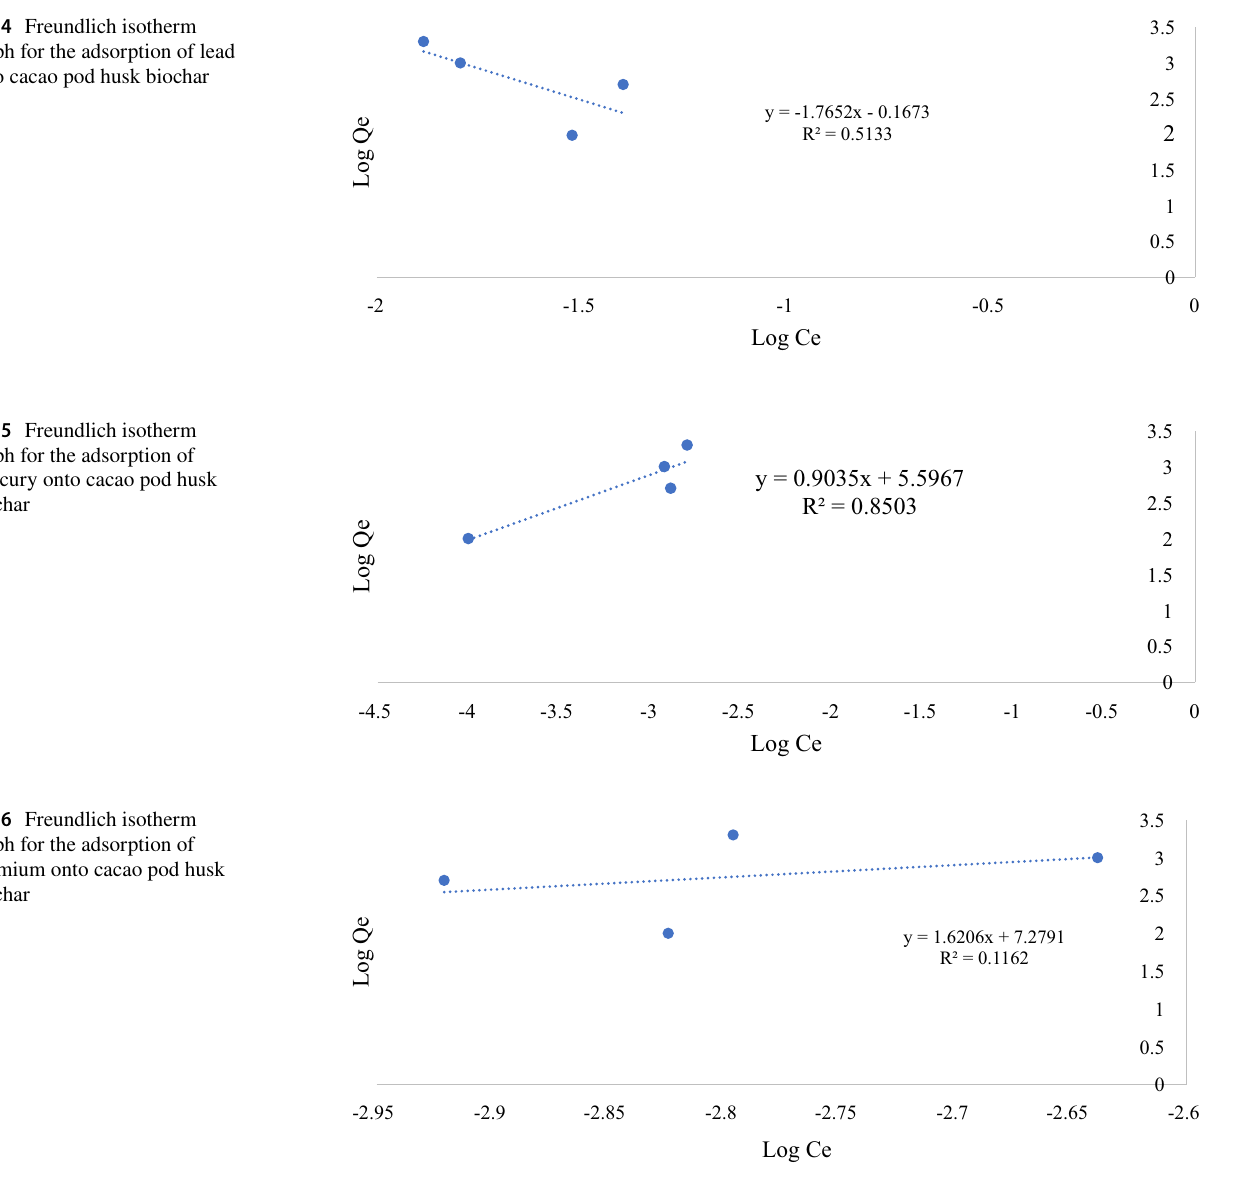
Fig. 4 Freundlich isotherm graph for the adsorption of lead onto cacao pod husk biochar